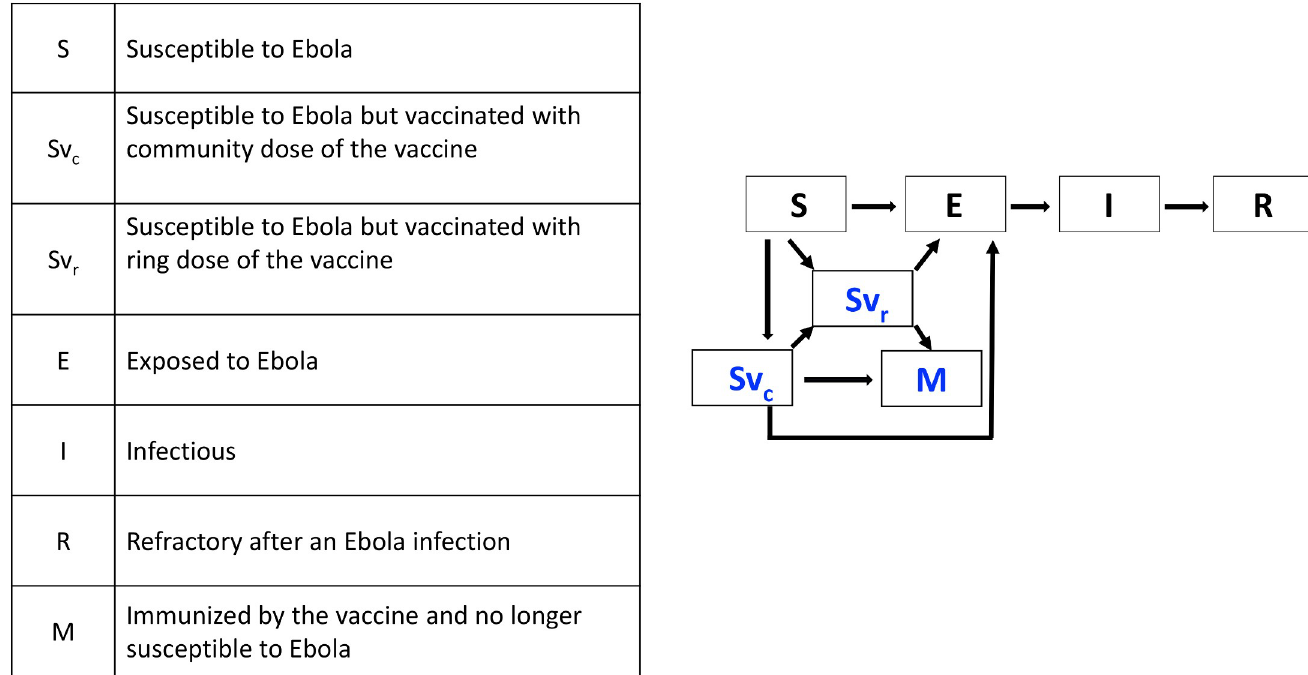
Fig 1. The seven epidemiological states for individuals in the population and the transitions between states. Susceptible (S) and individuals vaccinated with either the ring or community dose of vaccine (Svr, SVc) may become exposed (E). Once exposed, individuals eventually become infectious and then refractory. Vaccinated individuals that do not become exposed eventually become immunized (M).